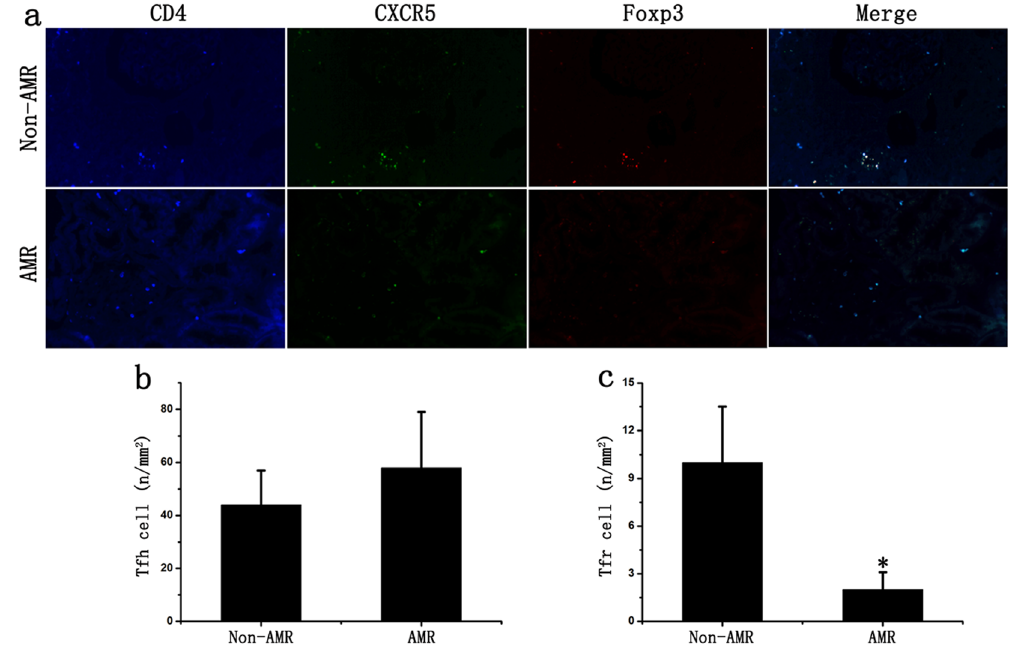
Figure 2. Changes of Tfr cells in renal graft tissues. ( a ) The number of Tfh cells and Tfr cells in renal graft tissues of CRAD patients was detected using immunofluorescence staining. ( b ) There is no statistical difference with the number of Tfh cells between AMR group and non-AMR group. ( c ) The ratio of Tfr cells in renal graft tissues of AMR group was significantly lower than that of non-AMR group. Two-sided Wilcoxon rank sum test: * p < 0.05 (n = 10) versus Non-AMR. Values are mean ±